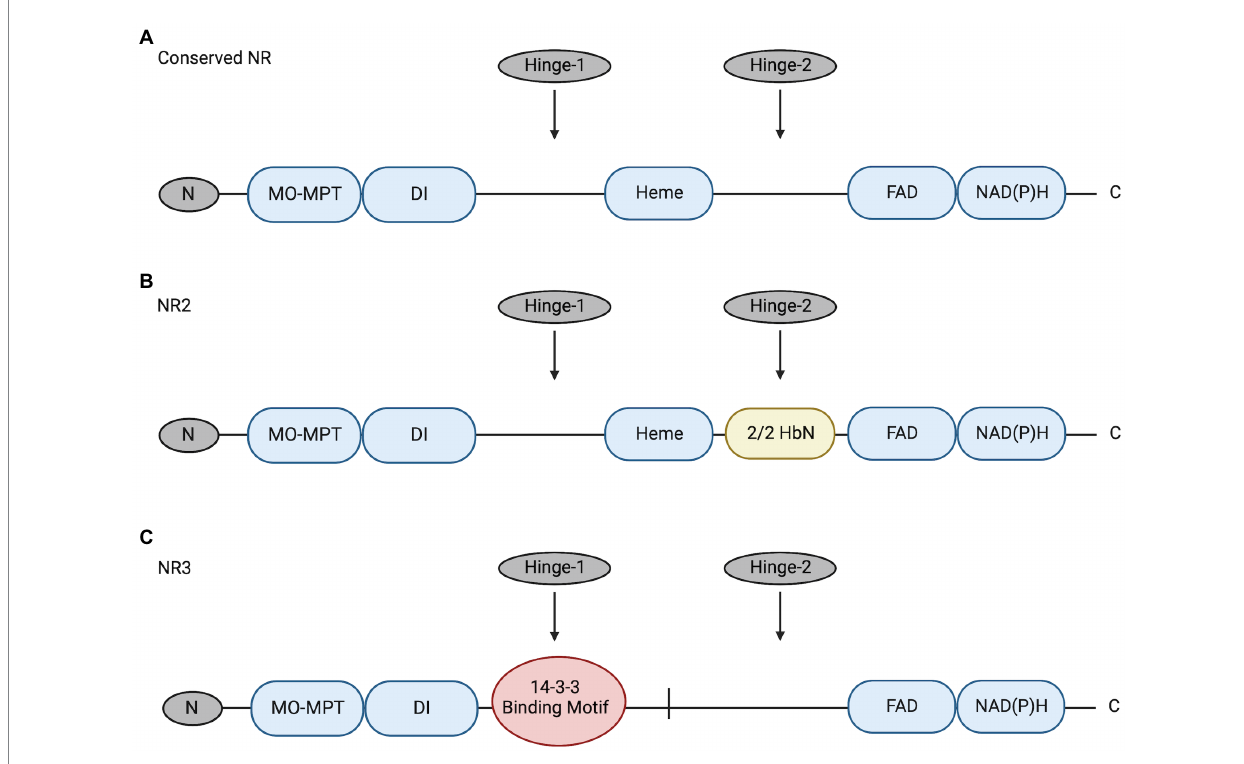
FIGURE 1 (A) Conserved NR structure includes 5 domains (blue; Mo-MPT, DI, Heme, FAD, and NAD[P]H) and 3 regions (grey; N, Hinge-1, and Hinge-2) (Campbell, 1999). (B) Structure of NR2 has a 2/2HbN domain (yellow) inserted in the Hinge-2 region. This enzyme was identified in raphidophytes Heterosigma akashiwo and Chattonella subsalsa (Stewart and Coyne, 2011). (C) Structure of the novel NR3 enzyme in C. subsalsa that lacks the conserved Heme domain and has a 14-3-3 binding motif (red) in the Hinge-1 region (Wang et al., 2018). The figure was created with Biorender.com and modified from Wang et al.